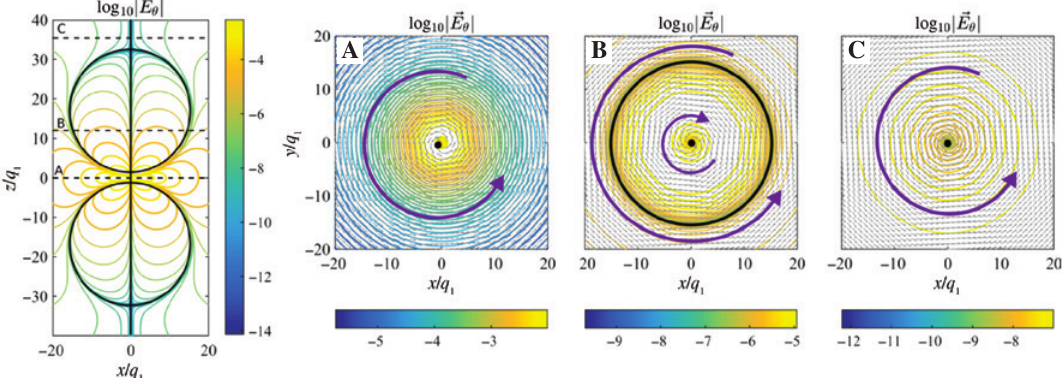
Figure 3: Electric field topology of the 1½-cycle TE FD pulse at focus. The left panel presents an isoline plot of the logarithm of the electric field in the xz plane. Solid black lines indicate the zeros of the electric field. Dashed lines marked as A–C indicate the z -levels of the cross-sections on the three right panels. Panels (A–C) present isoline plots of the logarithm of the electric field and arrow plots of the electric field direction in the xy plane. Solid black lines and black dots mark the points and areas, where the electric field vanishes. Purple arrows indicate the direction of the electric field and serve as guide to the eye. The pulse is at focus ( t = 0) and propagates along the positive z